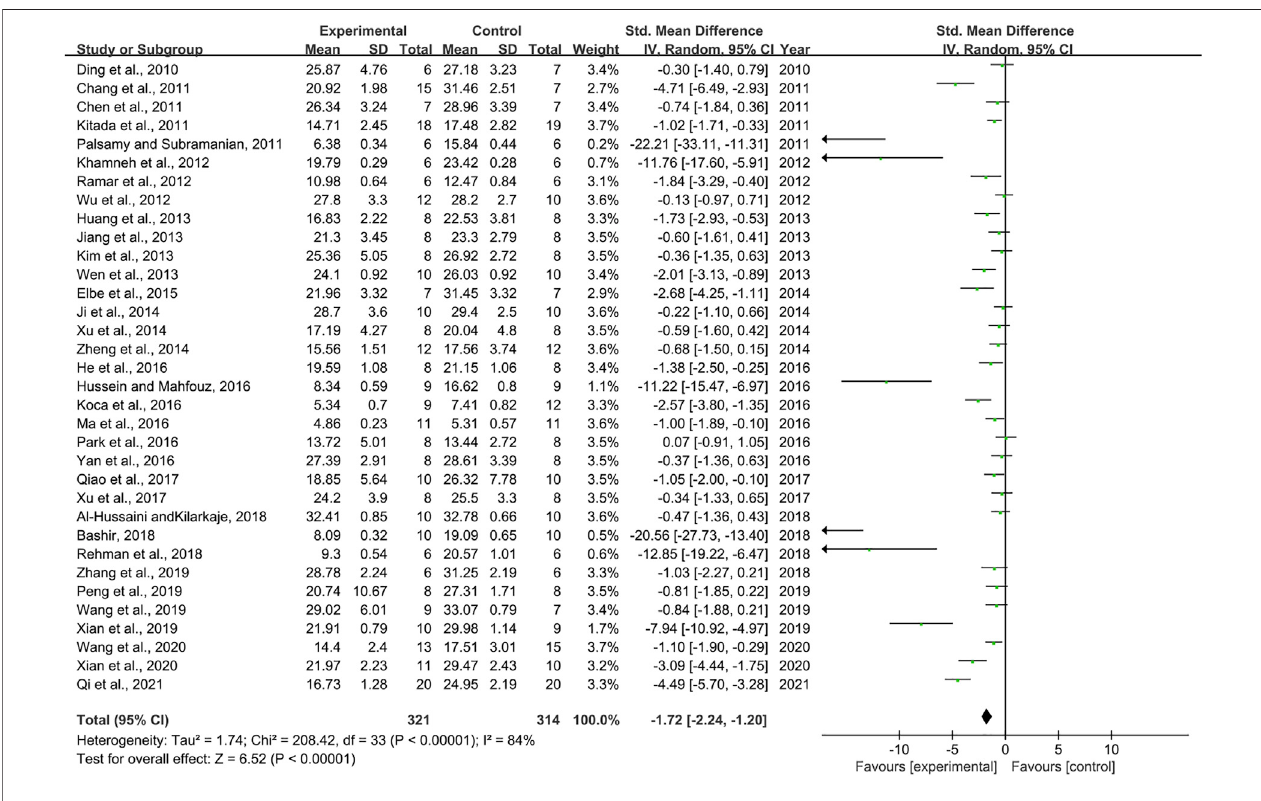
FIGURE 2 | Pooled estimate of BG with